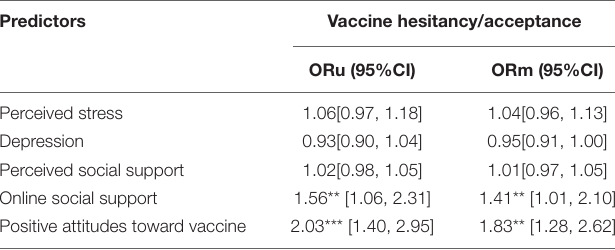
TABLE 4 | Predictors of vaccine hesitancy/acceptance by multiple logistic regression model ( N =